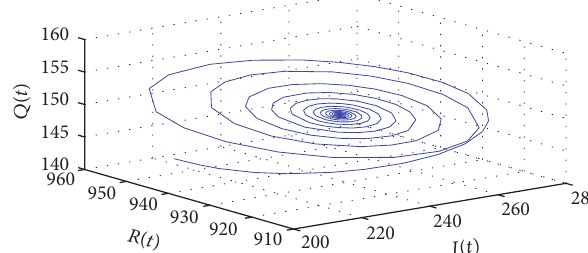
= 2.86 and 𝜏 = 2.25 ∈ (0,𝜏 ) . 1 2 20